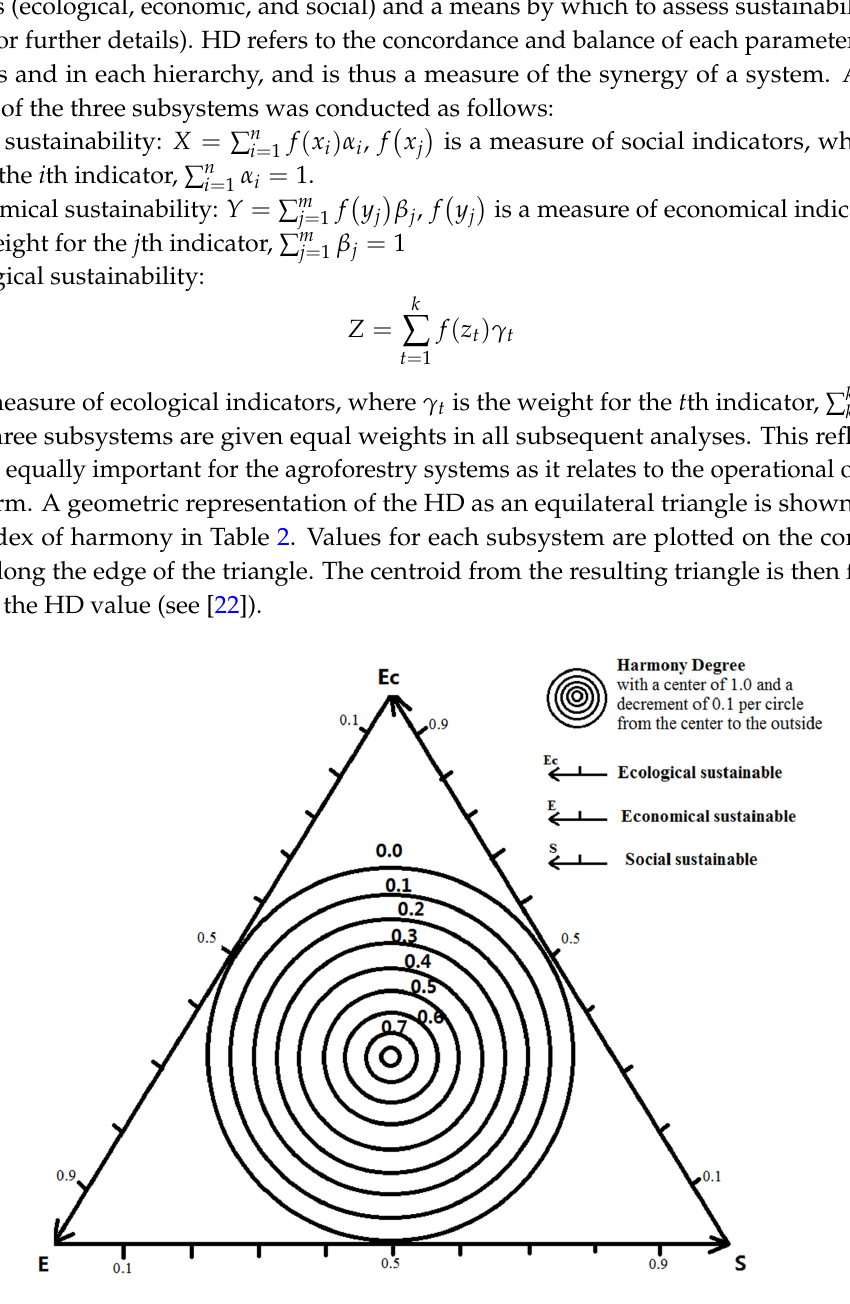
Figure 2. Equilateral triangle of the three sustainability subsystems, ecological (Ec), economic (E), and social (S). Concentric circles represent the different combinations of the subsystems, which gives rise to variation in the Harmony Degree (HD) index. The HD index varies from 0 to 1.